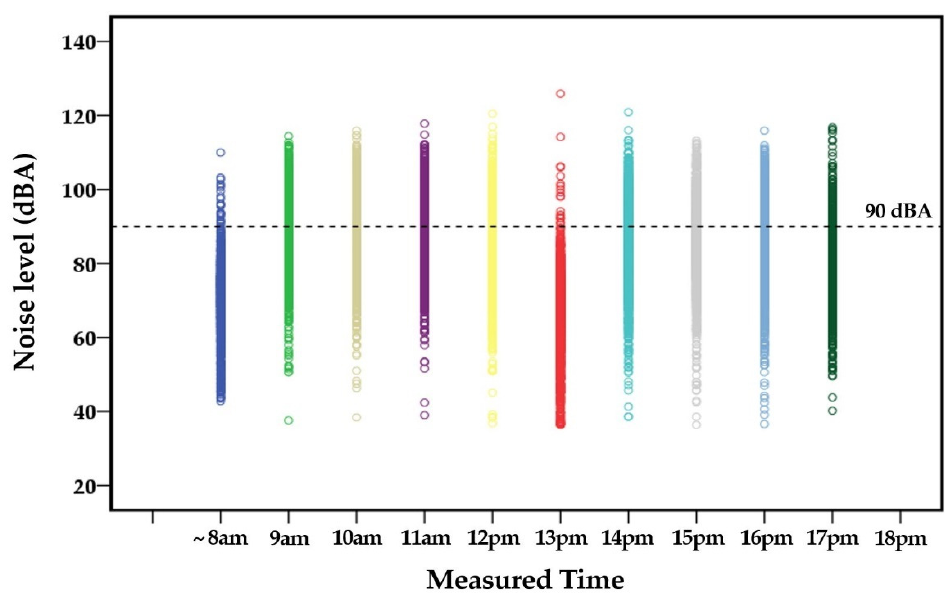
Figure 2. Noise exposure levels of all study subjects ( N = 1575) at each measured time per day.